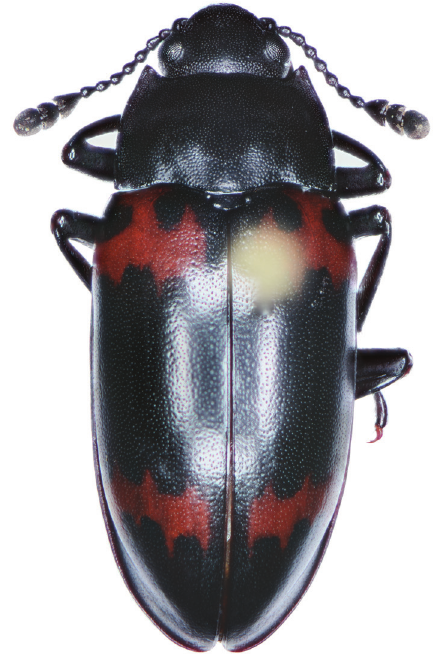
Figure 87. Dorsal habitus and color pattern of fungus beetle sp. (Erotylidae: Megalodacninae) observed on bracket fungus living together with both larvae and adults of Lioptera erotyloides